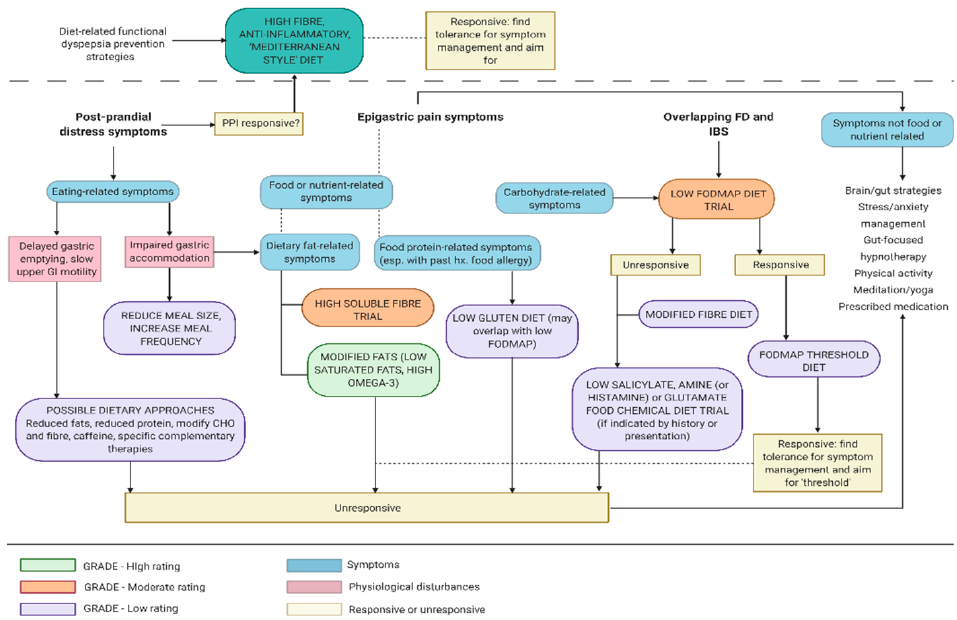
Figure 1. Functional dyspepsia dietary management flow chart based on food-nutrient-symptom presentations and informed by the Grading of Recommendations, Assessment, Development and Evaluations (GRADE) framework for clinical practice